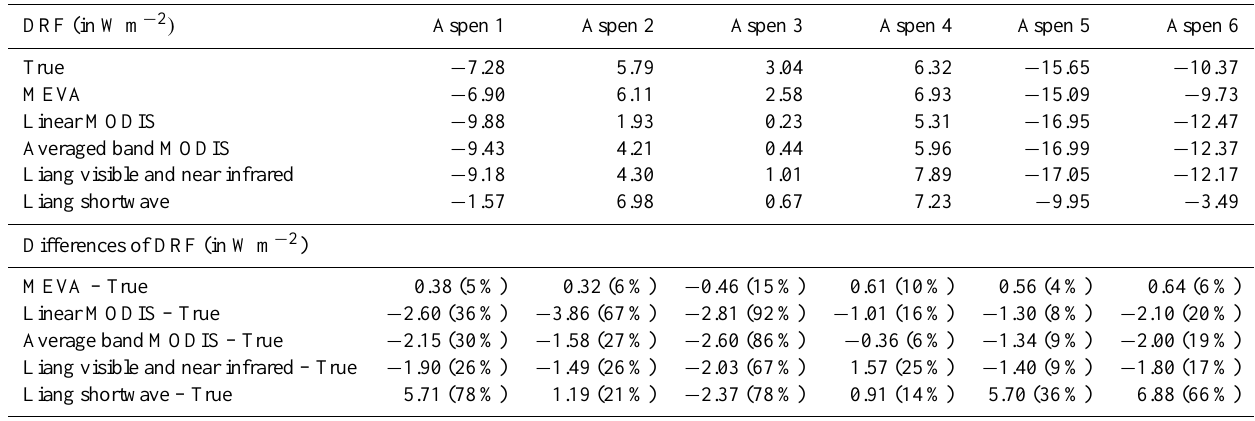
Table 5. The calculated instantaneous aerosol DRF (in Wm − 2 ; from 0.3 to 2.5µm) over aspen surfaces. Other parameters used in the calculation include AOD (at 0.55µm) of 0.32; SSA (at 0.55µm) of 0.89; and SZA of 30 degrees. Bold numbers represent the differences of aerosol forcing associated with applying different approaches and “true”; the numbers in parentheses represent the ratio of the absolute difference in aerosol forcing to the results calculated with “true”.